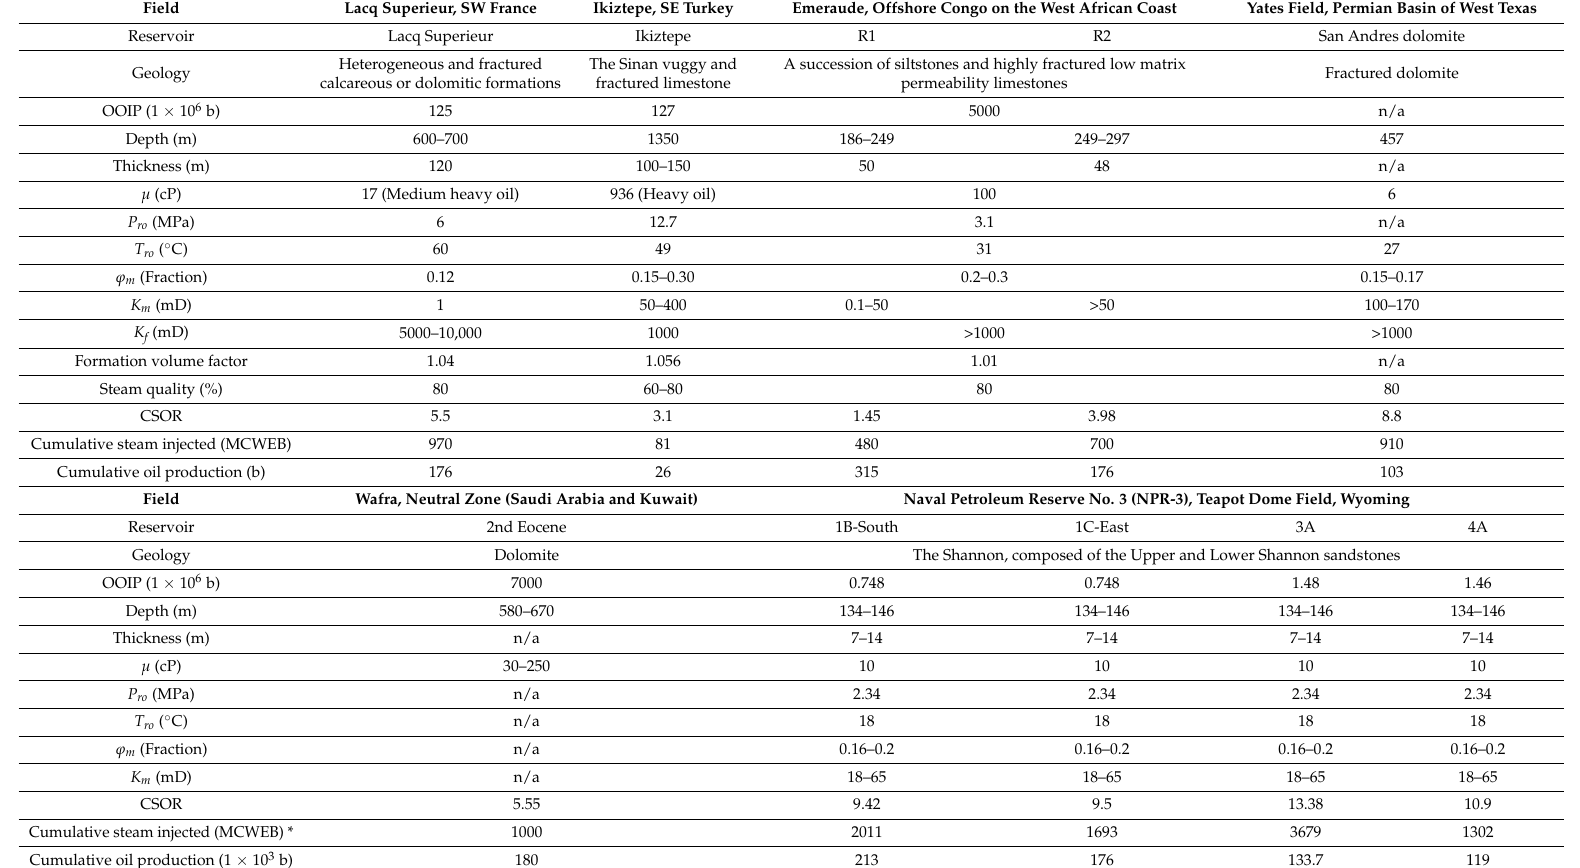
Table 2. Characteristics of the steamflooding field pilots conducted in